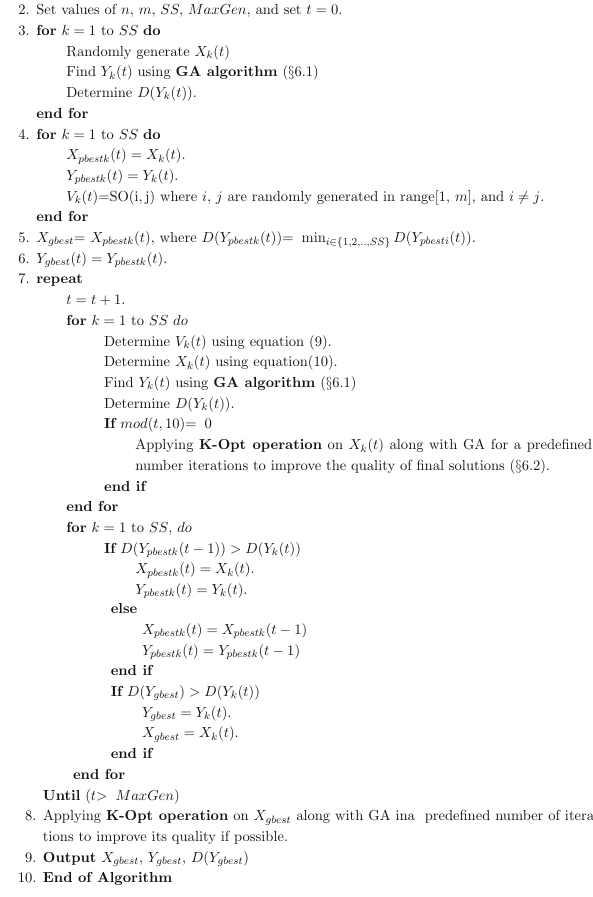
A Hybrid algorithm based on SSPSO and GA algorithm with a local search (K-Opt) for GTSP Consider a GTSP with n cities { v 1 , v 2 , . . . , v n } and m groups { g 1 , g 2 , . . . , g m } .